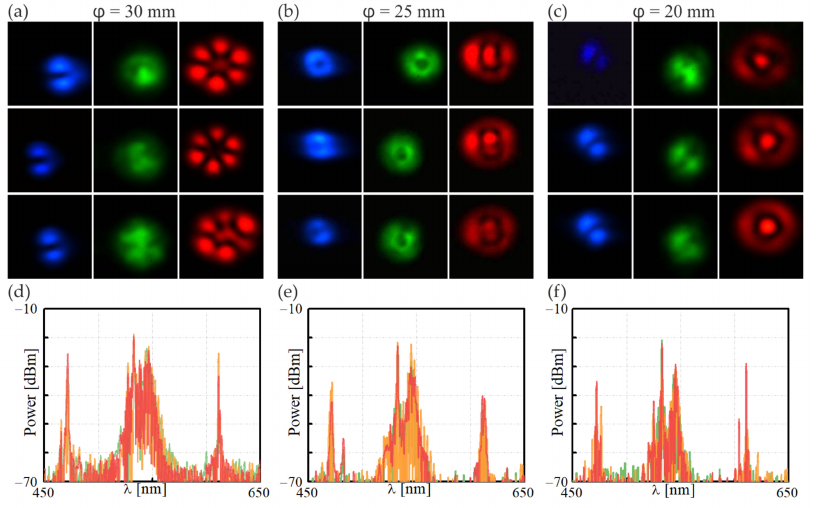
Figure 5. Anti-Stokes, pump, and Stokes optical field distribution ( left , middle, and right panels, respectively) obtained in the IM-FWM process (P 532nm = 8.0 mW) in FUTs with different amounts of optical birefringence and as a result of winding fiber on spools of varying diameters: ( a ) ϕ = 30 mm, ( b ) ϕ = 25 mm, and ( c ) ϕ = 20 mm. Each sub-section’s top, middle, and bottom panels refer to the polarization of a pump beam: parallel, tilted at 45 ◦ , and orthogonal to the winding plane, respectively; ( d – f ) spectral characteristics correspond to the panels ( a – c ) for the pump beam polarized at 0 ◦ (green line), 45 ◦ (orange line), and 90 ◦ (red line),